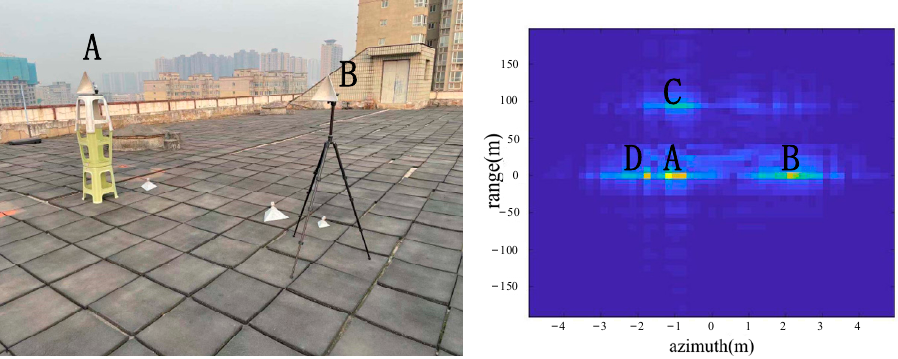
Figure 8. The 3rd group of experimental scenes and imaging results. As shown in Figure 9, two corner reflectors A and B were placed in the azimuth direction 17 m from the radar. The two corner reflectors A and B were 2.5 m apart in the azimuth direction. The corner reflector A was on the left, and the corner reflector B was on the right. A was a big one, and B was the small one, so the reflection of A was stronger than the reflection of B. According to the imaging results, the positions of A, B, C and D were consistent with the positions of objects in the actual scene.